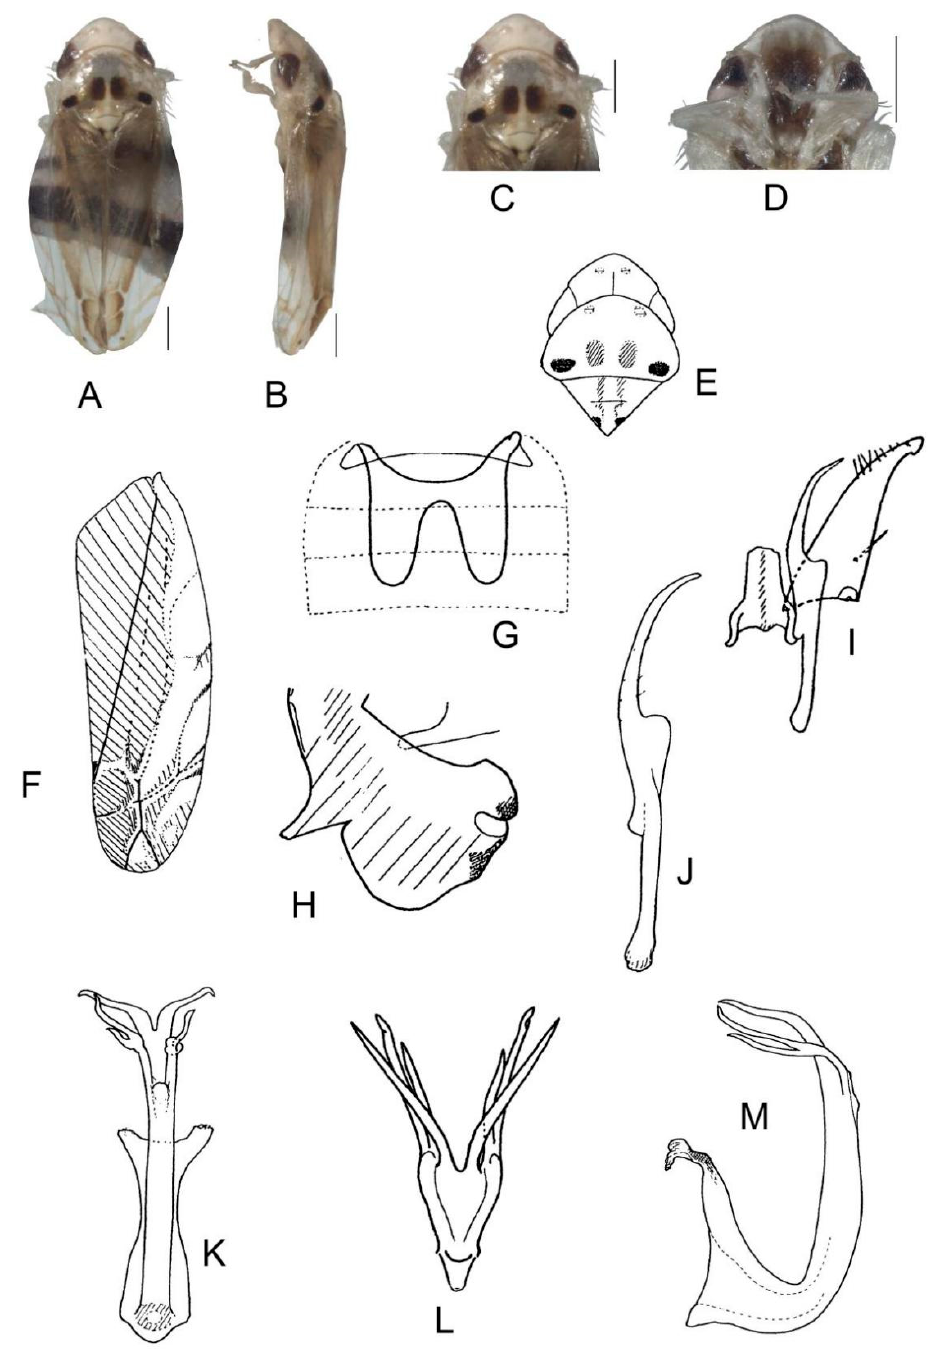
Figure 24. Eurhadina ( Singhardina ) jarrayi rec. nov. ( E – M : Dworakowska, 2002 [3]): ( A ) habitus, dorsal view; ( B ) habitus, lateral view; ( C ) head and thorax, dorsal view; ( D ) face; ( E ) head and thorax, dorsal view; ( F ) forewing; ( G ) abdominal apodemes, dorsal view; ( H ) pygofer side, lateral view; ( I ) subgenital plate, connective and paramere, dorsal view; ( J ) paramere, dorsal view; ( K ) aedeagus, posterior view; ( L ) apex of aedeagal shaft, dorsal view; and ( M ) aedeagus, lateral view. Scale bars: 0.5 mm.